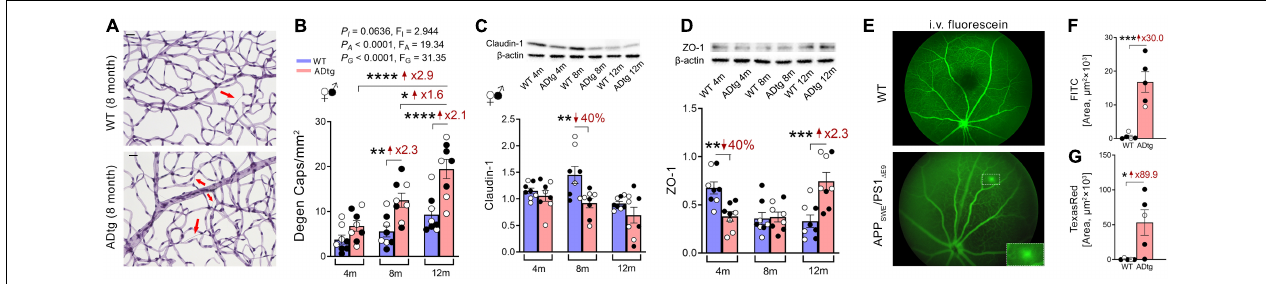
FIGURE 2 | Retinal vasculopathy in APP SWE PS1 (cid:49) E9 (ADtg) mice. (A,B) Representative images of periodic acid-Schiff (PAS)-stained, hematoxylin-counterstained isolated retinal microvasculature from ADtg and matched wild type (WT) littermates. Acellular degenerated retinal capillaries are indicated by red arrows. (B) Numbers of degenerated retinal capillaries when mice are stratified by mouse genotypes, WT or ADtg, by age groups of 4, 8, and 12 months. (C,D) Western-Blot analysis of panel (C) claudin-1 and (D) ZO-1 in retinal lysates from 4, 8, and 12-month-old APP SWE PS1 (cid:49) E9 mice and WT controls. (E) Images showing in vivo retinal microvascular imaging for leakage after intraperitoneal fluorescein injection in 12-month-old WT and ADtg mice. (F,G) Quantitative analysis of the panel (D) FITC (1,000 kDa) or (E) Texas Red (3 kDa)-stained area in retinal flat-mounts from WT or ADtg mice. Black-filled circles represent males and clear circles represent females. Data from individual mouse as well as groups are shown as mean ± SEM. * p < 0.05, ** p < 0.01, *** p < 0.001, **** p < 0.0001, by 2-way ANOVA with Sidak’s post hoc multiple comparison test (more than 2 groups) or unpaired 2-tailed Student’s t test (2 groups). Fold and percentage changes are shown in red. Reproduced from Shi et al. (2020a) under terms of the Creative Commons Attribution 4.0 International License